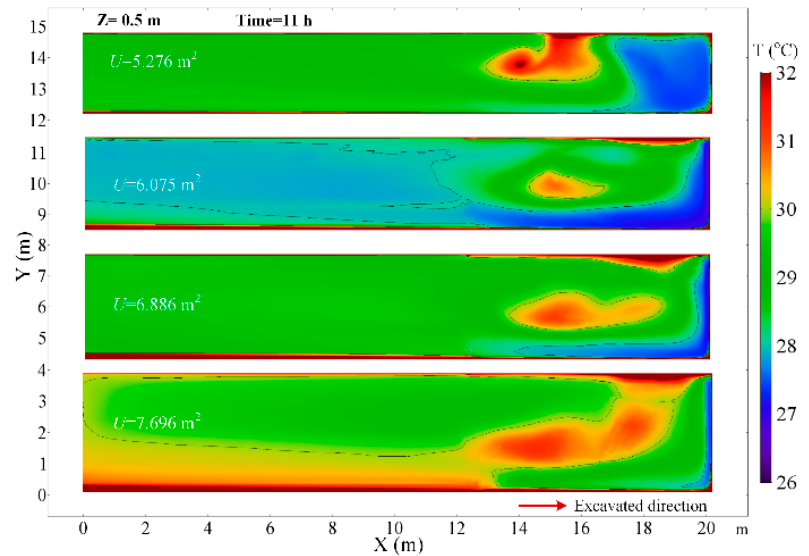
Figure 16. Airflow velocity distribution in Z = 1.0 m plane under different roadway section size.